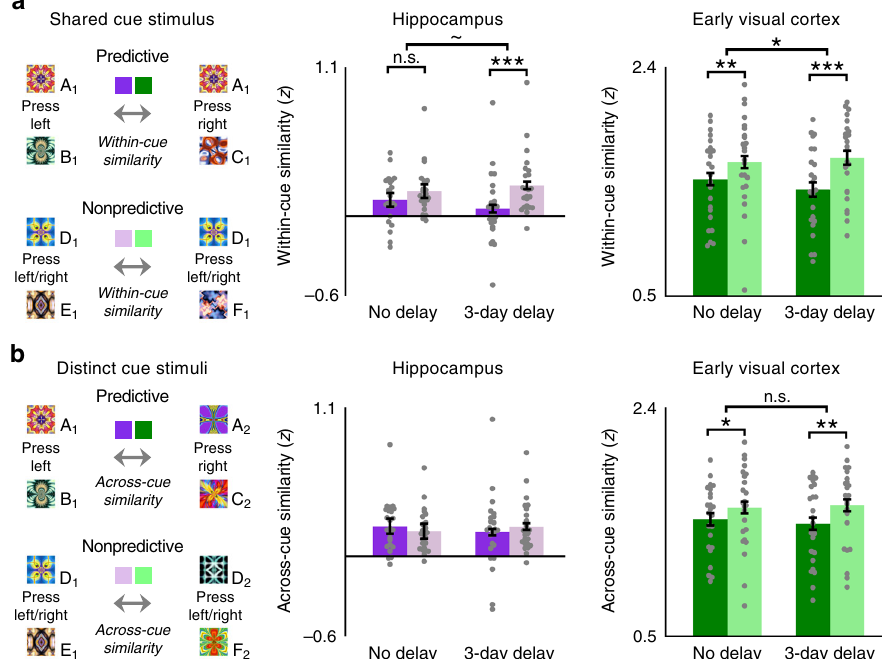
Fig. 7 Multivariate pattern similarity. a Within-cue pattern similarity was measured as the correlation across voxels between cue – outcome visual transitions that shared the same cue but contained different outcomes. Hippocampal and EVC within-cue similarity were lower for predictive than nonpredictive actions after a 3-day delay, compared to no delay. b Across-cue pattern similarity was measured between cue – outcome transitions with non- overlapping stimuli. Delay interval did not modulate across-cue similarity in either the hippocampus or EVC. Error bars indicate ± 1 SEM of the difference between correlations for predictive and nonpredictive events at each timescale. *** p < 0.001; ** p < 0.01; * p < 0.05; ~ p = 0.051 (paired t -tests). Source data are provided as a Source Data fi